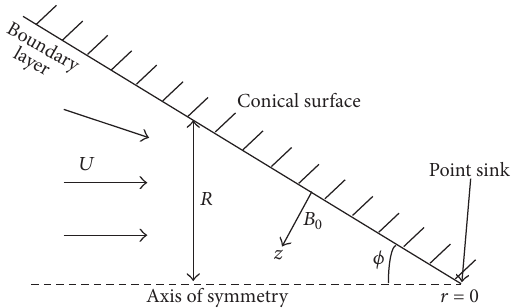
Figure 1: Schematic diagram of the flow